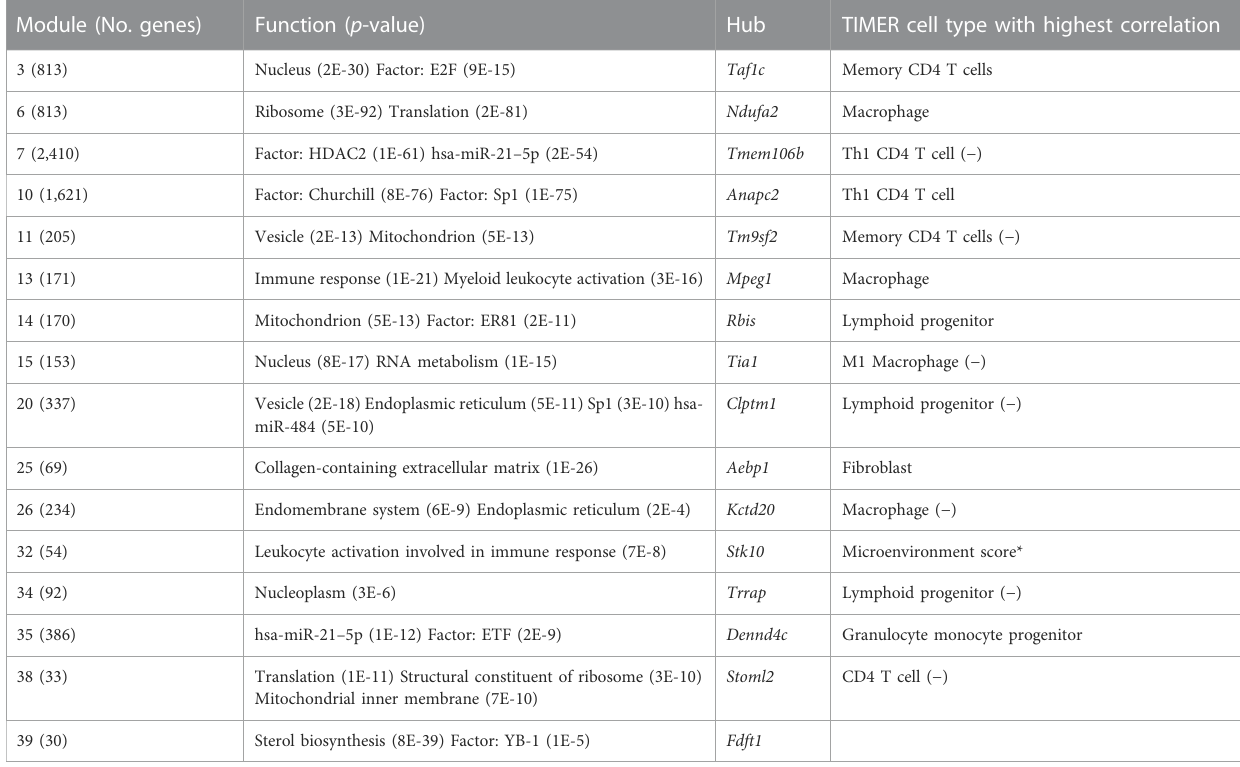
TABLE 2 Functional enrichment analysis for the sixteen modules identi fi ed in the NAFLD dataset GSE135251. Module (No.